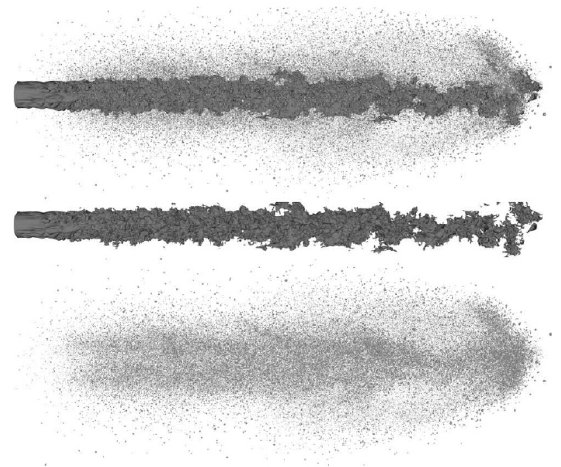
Figure 10. A jet spray result by hybrid approach [57]. The nozzle diameter is D nozzle = 0.1 mm and the injection velocity is U inj = 100 m/s. The top image is a combination of resolved liquid core and Lagrangian droplets, the central image shows the core and the bottom image shows the Lagrangian droplets. Reproduced with permission from Elsevier.